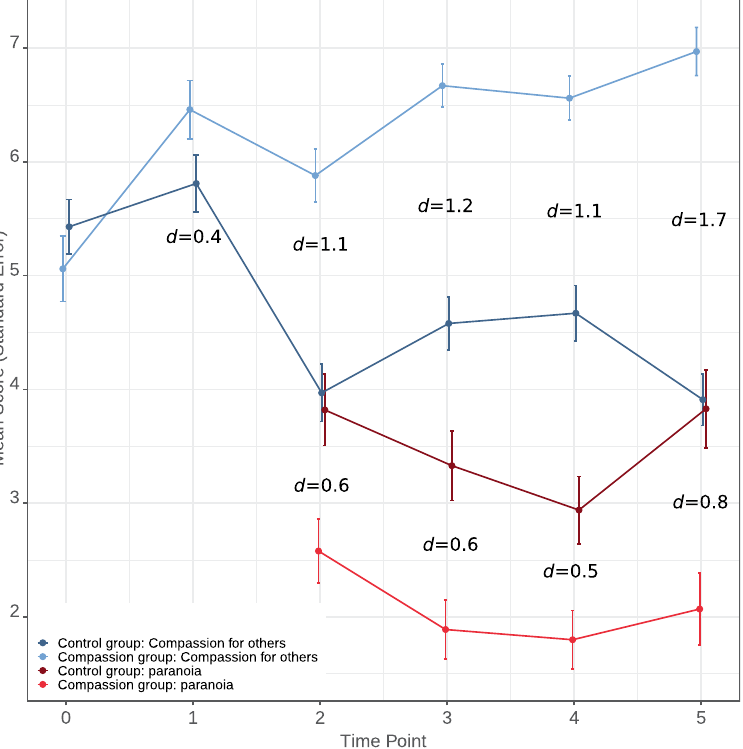
Figure 3. Scores and effect sizes for primary compassion and paranoia outcomes (study